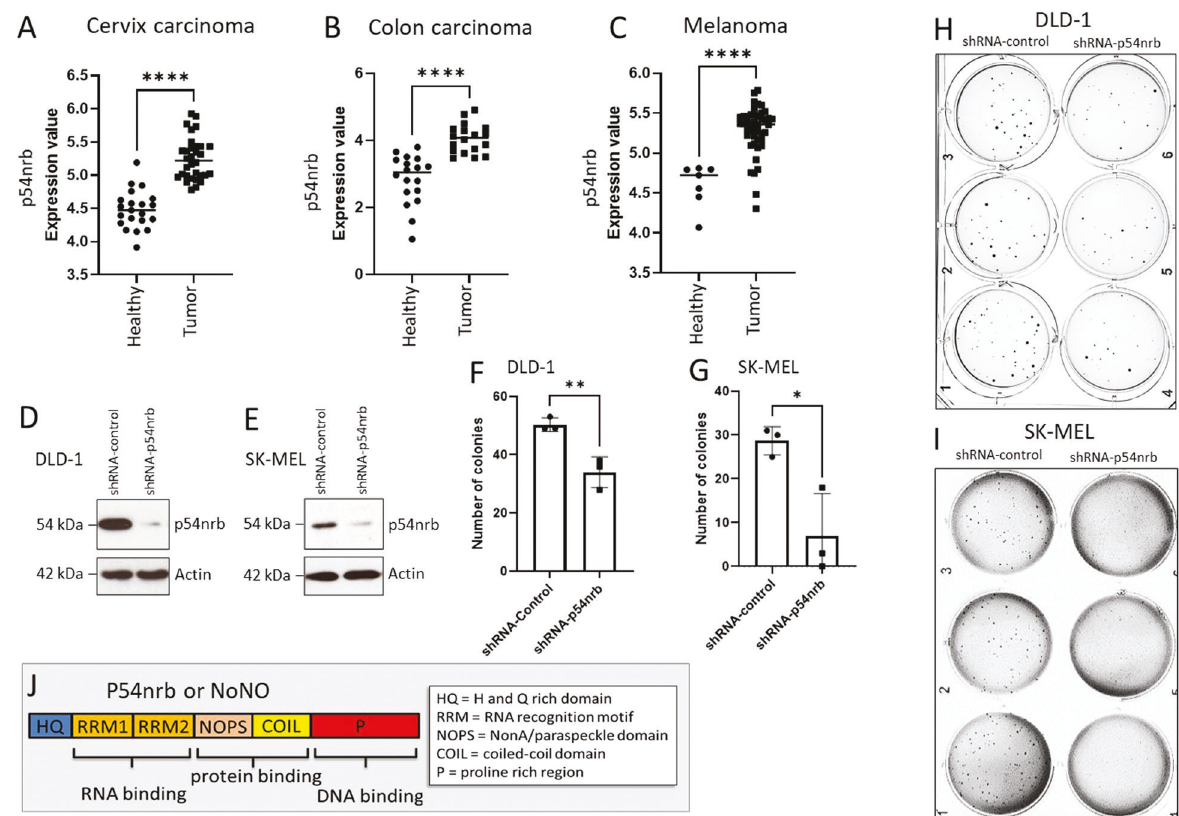
Fig. 1 Depletion of p54nrb lowers the viability of tumor cells. P54nrb expression level in healthy tissue versus tumor tissue A from cervix carcinoma, B from colon carcinoma, and C from melanoma patients. Values were obtained from Oncomine database. To test signi fi cance Student´s t test was performed. **** p < 0.0001. Immunoblot of p54nrb-level in shRNA-control and shRNA-p54nrb#1 knockdown cells D from DLD-1 and E from SK-MEL. Counts of colonies of 3D soft agar tumor growth assay of shRNA-control and shRNA-p54nrb#1 cells F from DLD-1 and G from SK-MEL. 1000 cells/well were seeded and grown for 3 weeks and stained with 0.1% crystal-violet. Student´s t test was performed. * p < 0.05, n = 3 ( G ). Representative wells of 3D soft agar tumor growth assay of shRNA-control and shRNA-p54nrb#1 cells H from DLD-1 and I from SK-MEL cells. J Schematic representation of protein domains of p54nrb (also: NoNO): H and Q rich domain (HQ), RNA recognition motif (RRM), NonA/paraspeckle domain (NOPS), coiled-coil domain (COIL), and proline-rich region (P). Brackets indicate the region for RNA, DNA, and protein